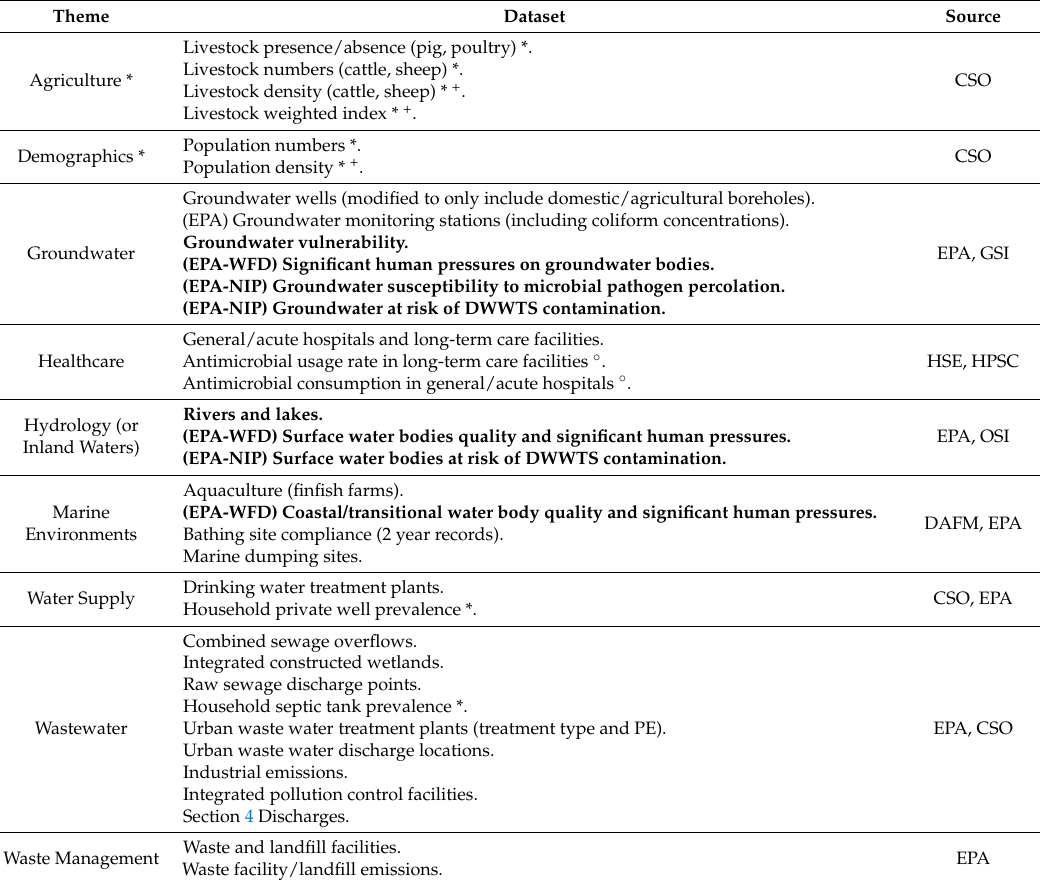
Table 1. Main themes and key datasets, inclusive of geographic information systems (GIS) shapefiles (feature classes) and attribute data, obtained and collated in the mapping